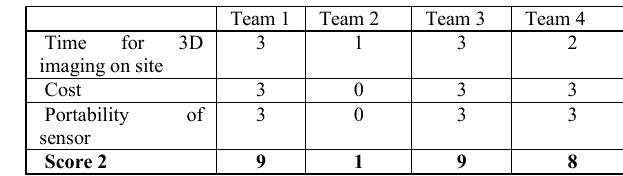
Table 6. Scores for tactics and strategy for all teams.